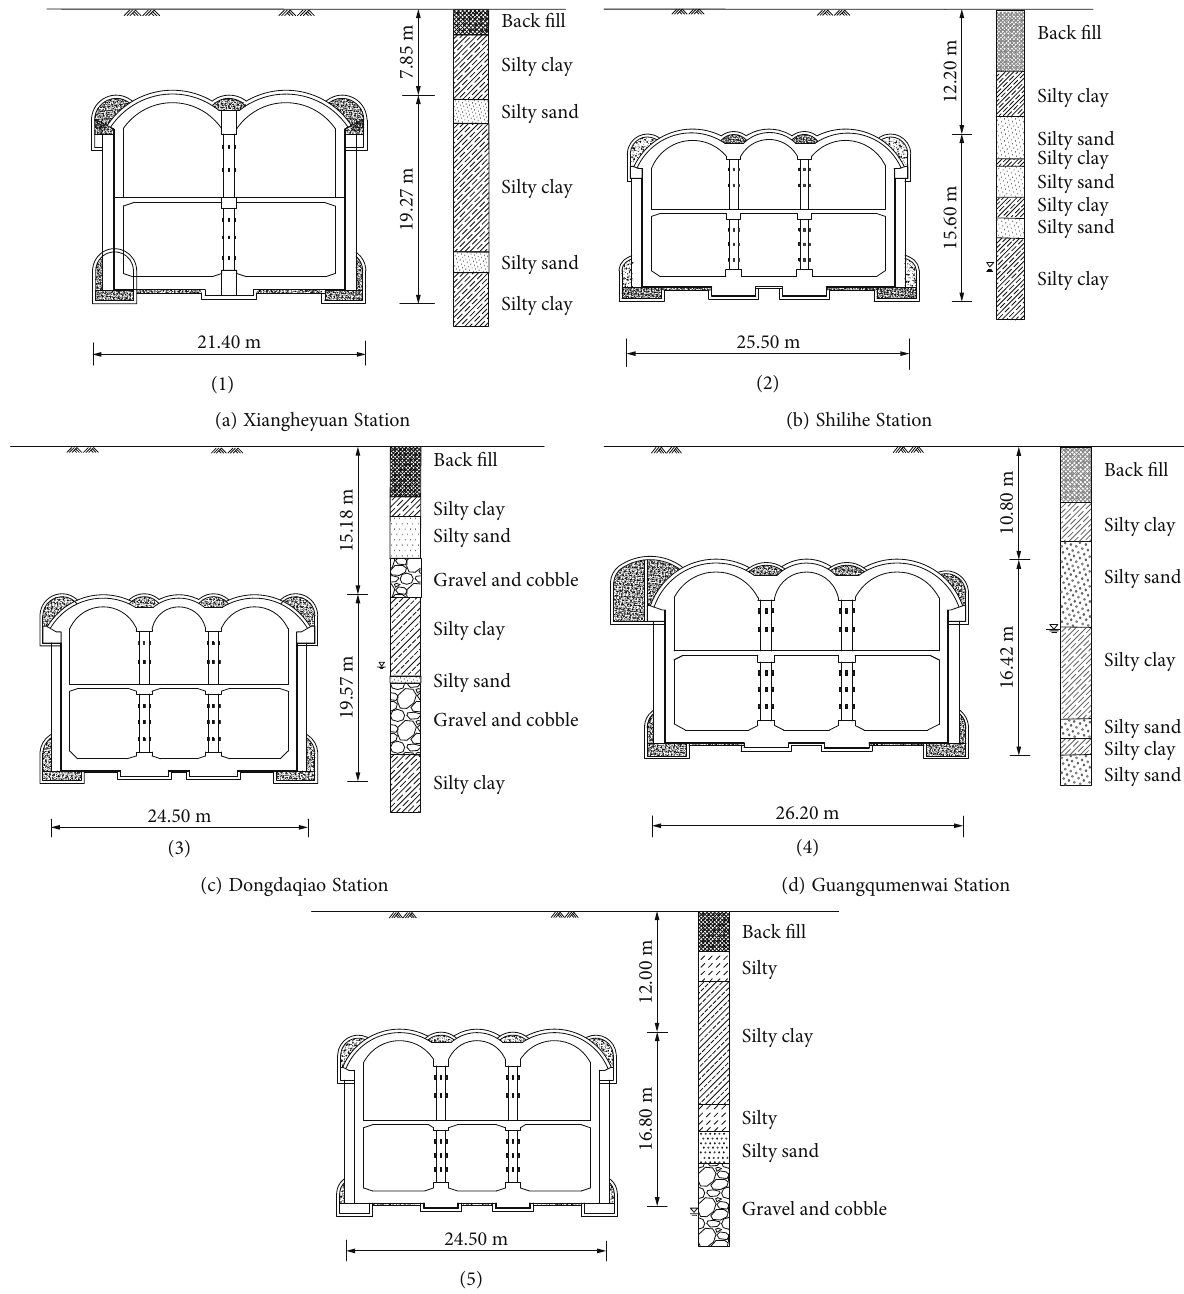
Figure 5: Cross sections of the strip foundation stations of the Beijing